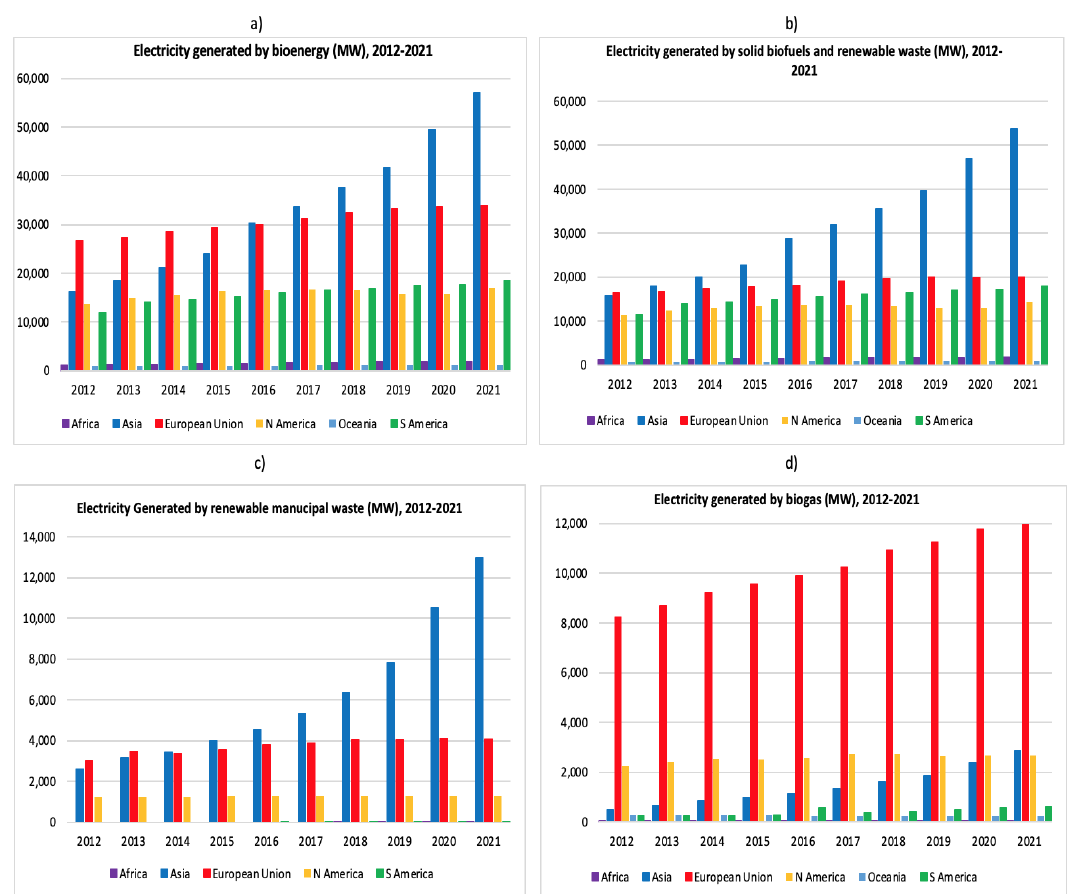
Figure 5. Electricity generated by type of waste renewable energy. Source of Data: International Renewable Energy Agency (IRENA) [124], Figures “ a ”, “ b ”, “ c ” and “ d ” show the generating capacity of power plants using bioenergy, biofuels, renewable waste, and biogas, respectively.